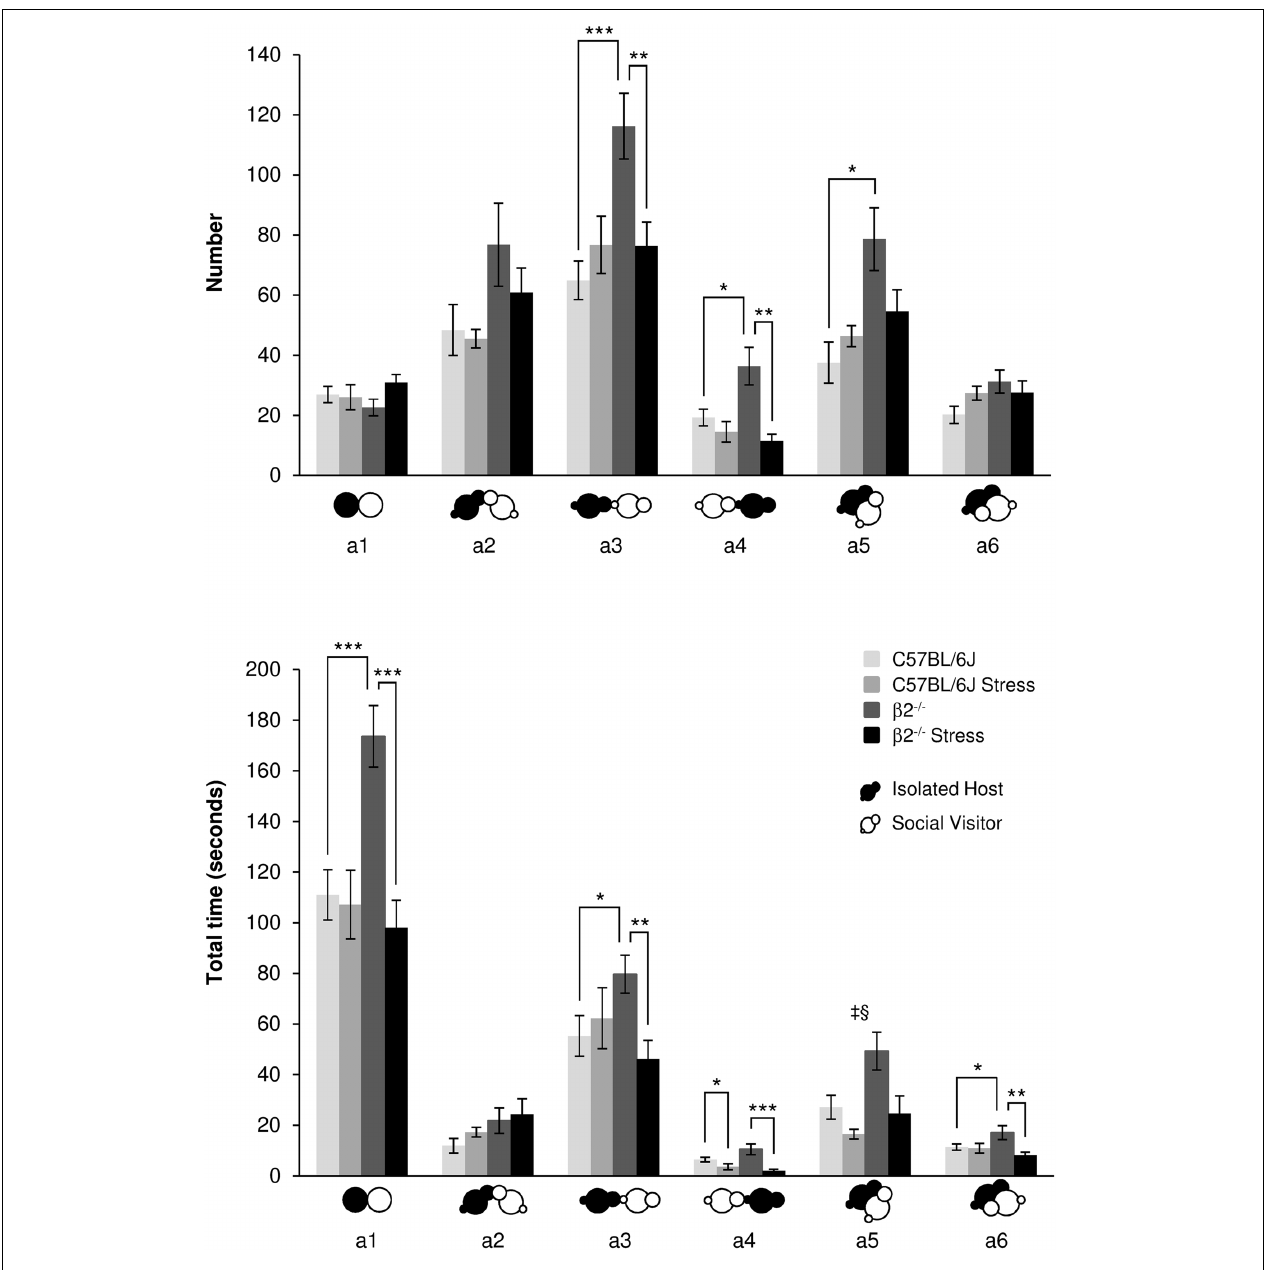
FIGURE 1 | Contact events during social interaction. The number ( Top ) and the total time ( Bottom ) of the different types of contact (a1 to a6 as referred in Table 1 and Supplementary Table 1) between IH and SV mice were quantified during the 4min of the social interaction task. IH mice